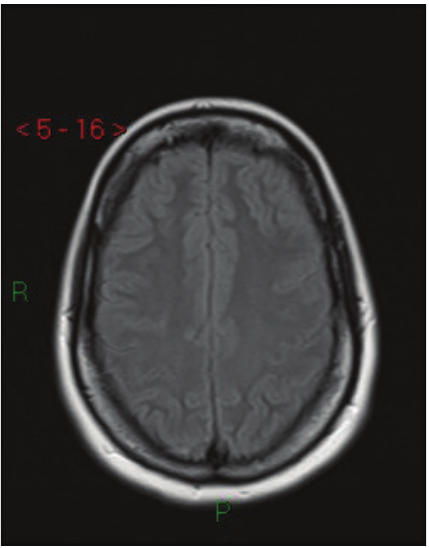
Figure 4: Case 2. Axial T2-FLAIR MRI: absence of lesions after 7